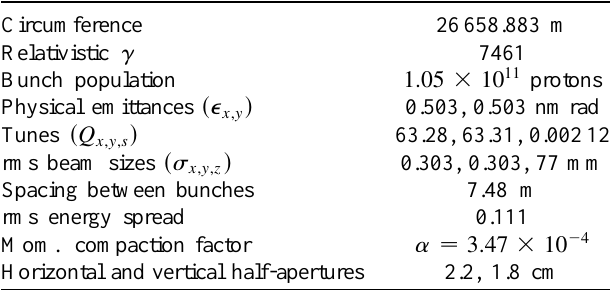
TABLE I. Overview on LHC parameters essential for the